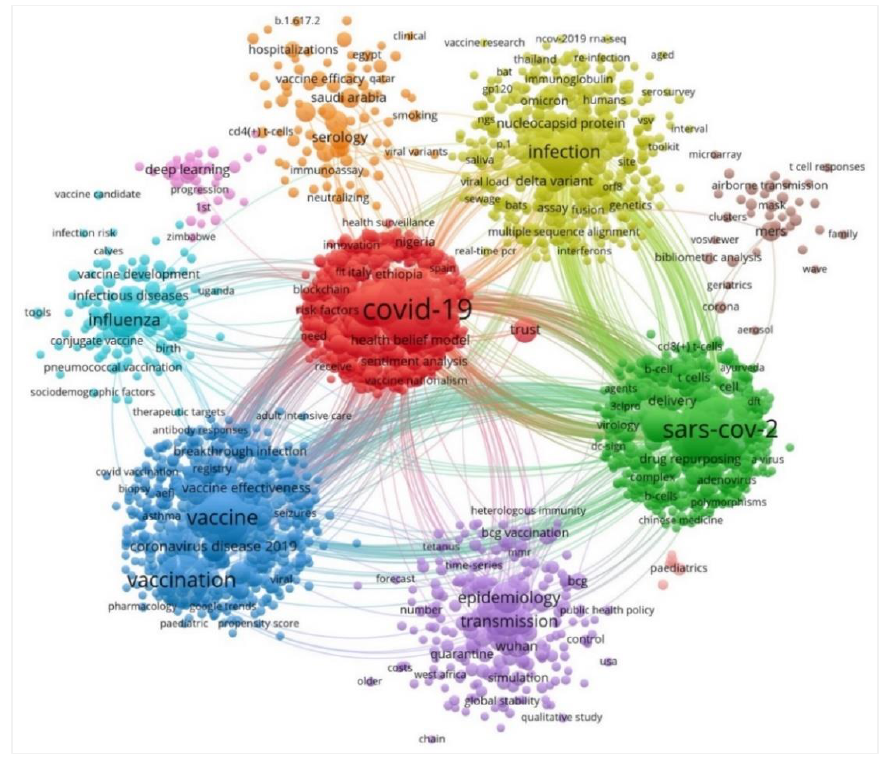
Figure 7. Keywords’ co-occurrence clusters visualization map in COVID-19 vaccine research, by VOSviewer analysis. The size of the nodes represents the occurrences of the keywords, and keywords with the same color in the view belong to the same clusters in the cooperation network.